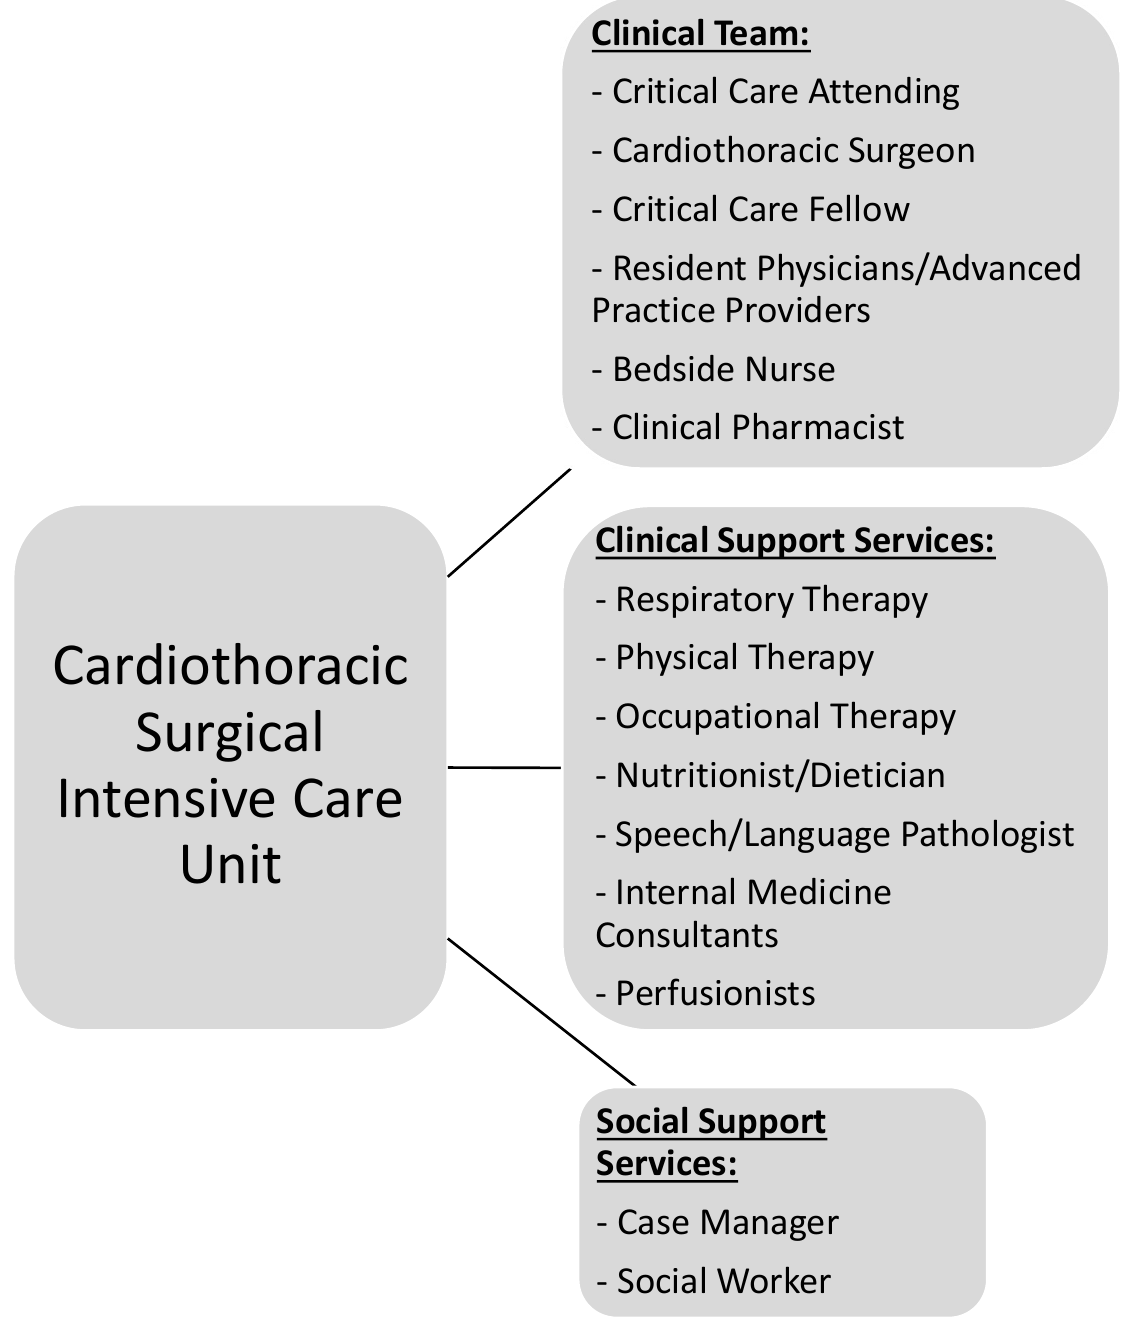
Figure 1. Representation of the most common network of team members required to be involved in patient care and multidisciplinary rounds in the CT-ICU due to the complex nature of critical illness. Table 1. Barriers to Knowledge Expansion in Cardiothoracic Surgical Critical Care Medicine.